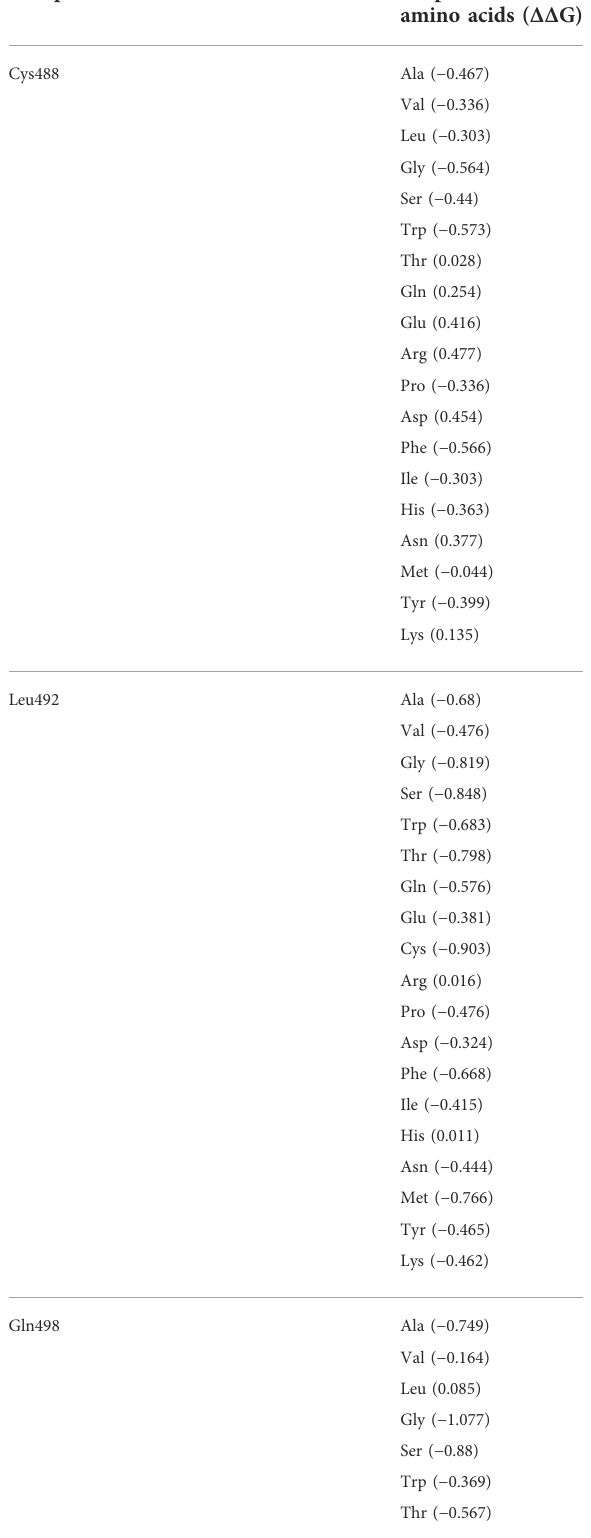
TABLE 3 The hotspot mutation results from mCSM server. Hotspot Proper